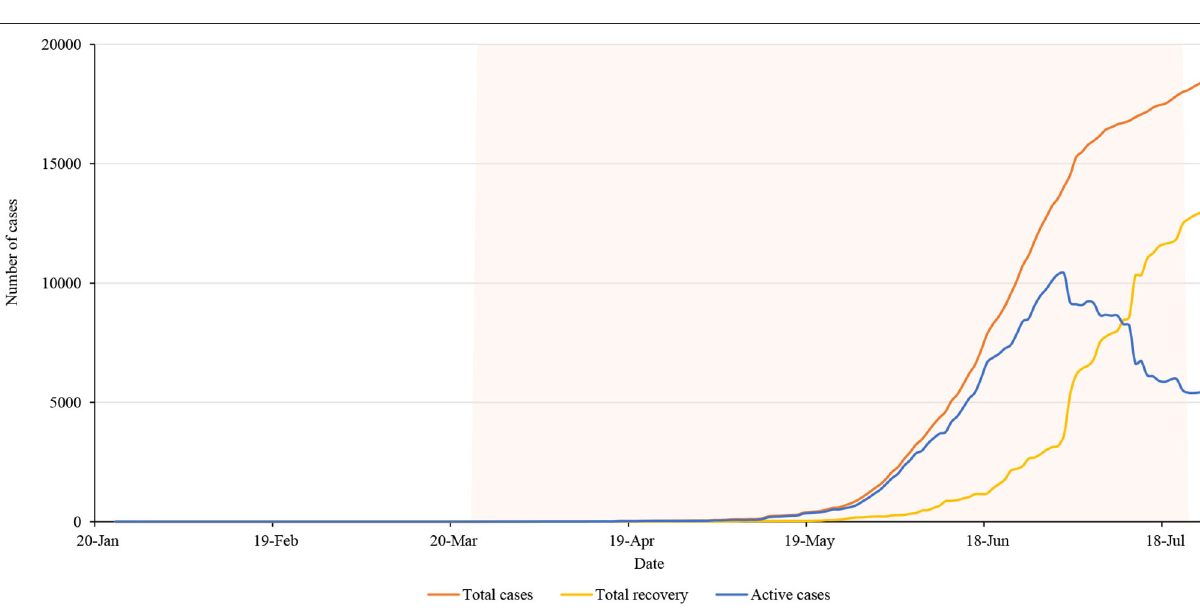
FIGURE 2 | Total cases, recovery and active cases in Nepal during the lockdown